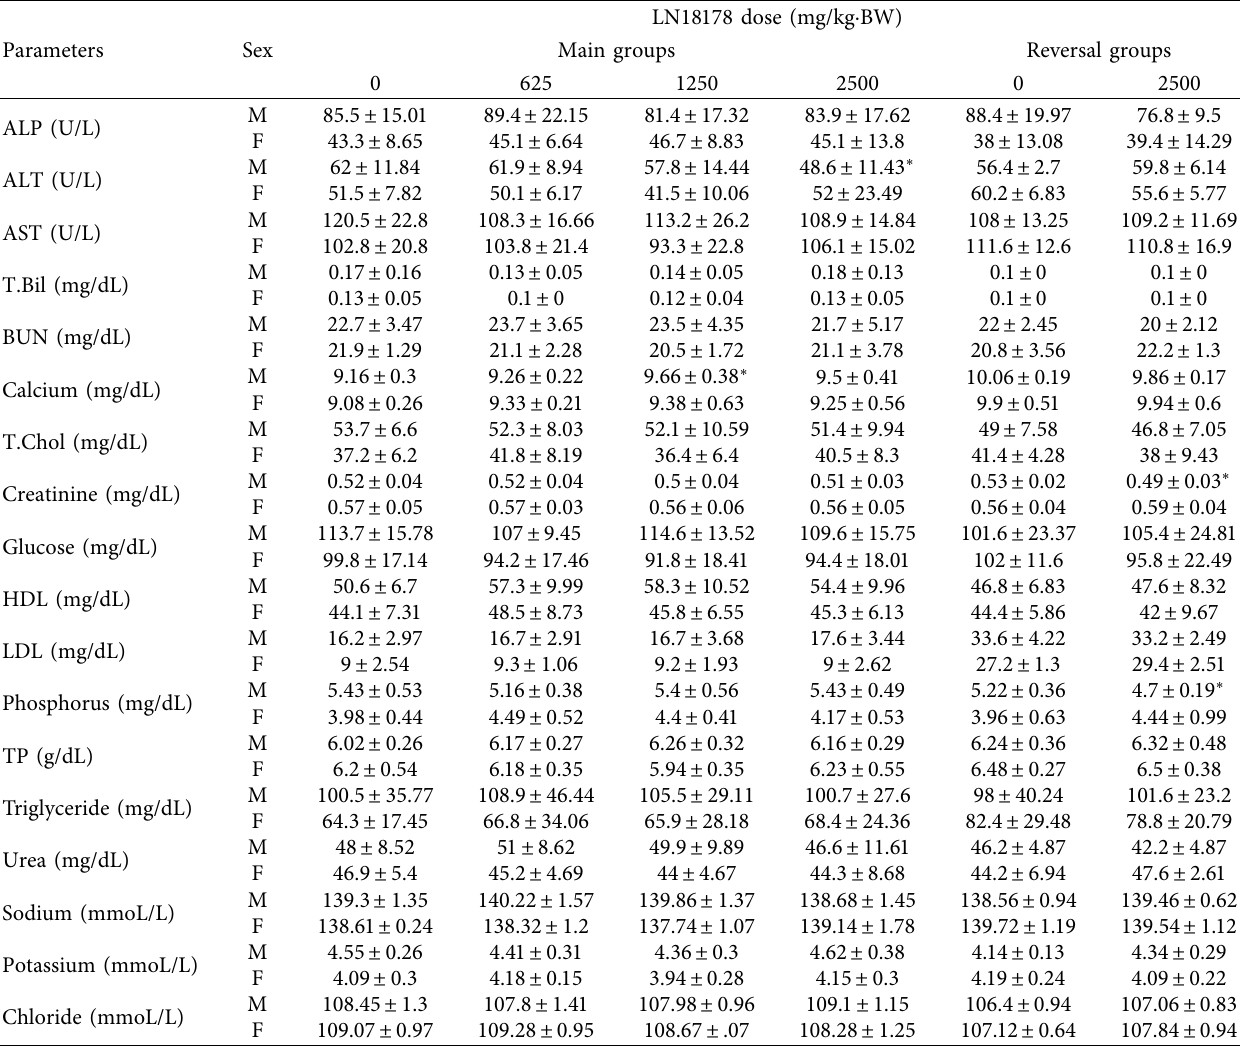
Table 4: Effect of 90-day oral administration of LN18178 on clinical biochemistry parameters of male and female Wistar rats.